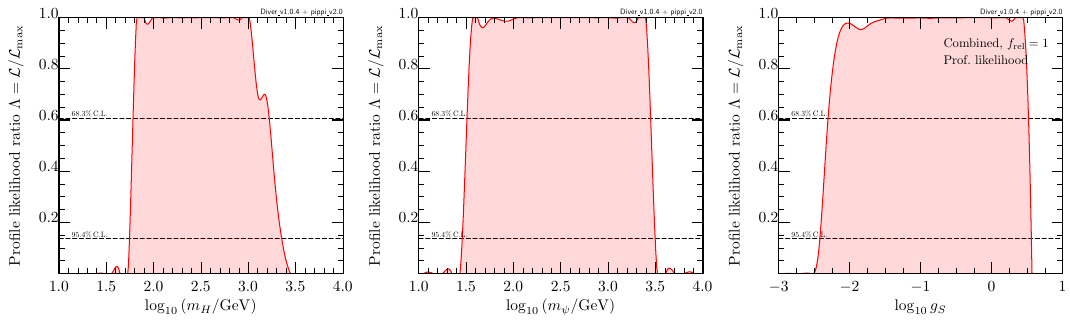
Figure 7 . Same as (cid:12)gure 5 except for the f